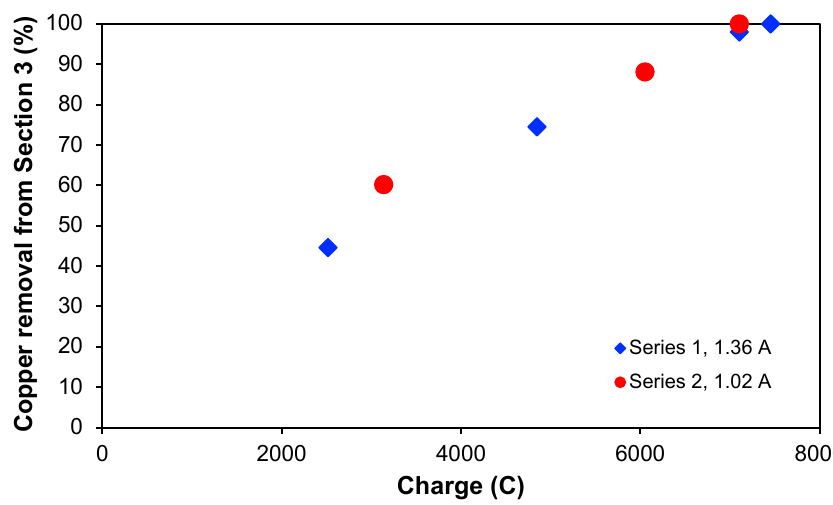
Figure 5. Copper removal (%) from Section 3 for series 1 and 2 as a function of passed electric charge.